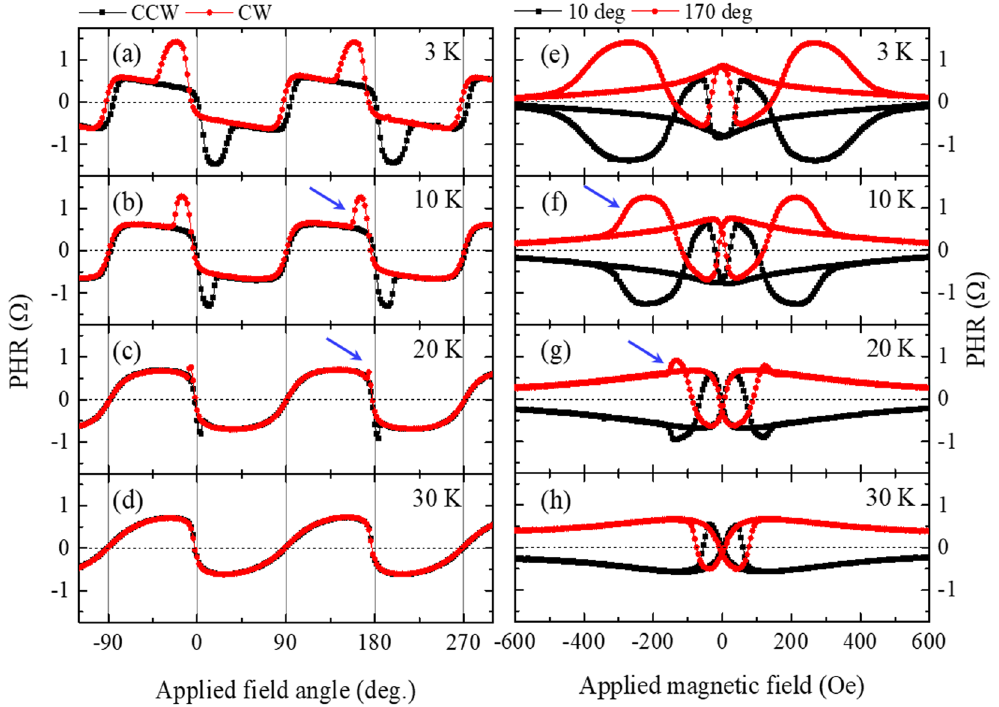
Figure 6. PHR data taken at four different temperatures. ( a )–( d ) Angular dependences of PHR taken by rotating a magnetic field of 200 Oe. Transitions appearing near 0° and 180° (i.e., near [110] and the [110] directions) rapidly diminish with increasing temperature. ( e )–( f ) Field scans of Hall resistance obtained with magnetic field along 10° and 170°. The hysteresis showing a larger coercive field disappears with increasing temperature. In both measurements, the contribution from the GaMnAs layer with positive Δ R disappears at a lower temperature than that from the layer with negative Δ R . As is typical for GaMnAs, coercive fields associated with the observed hysteretic behavior diminish rapidly as the temperature